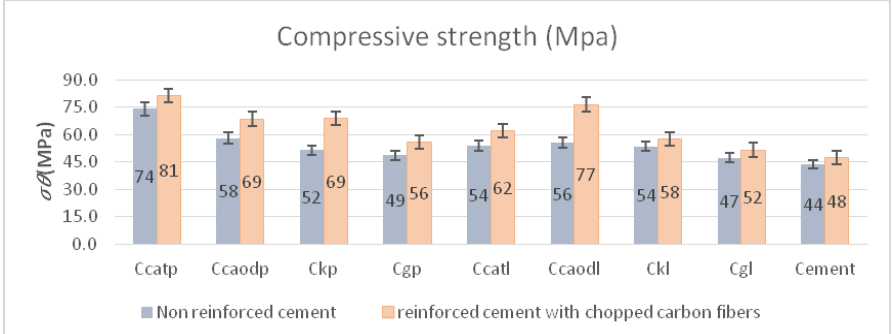
Figure 19. Compressive strength of cement specimens reinforced with chopped carbon fibers and non-reinforced specimens wrapped with composite materials of epoxy resin as a matrix and one- directional and two-directional carbon fiber fabric, glass fiber fabric and Kevlar for reinforcement. Variation of values: ±5%.